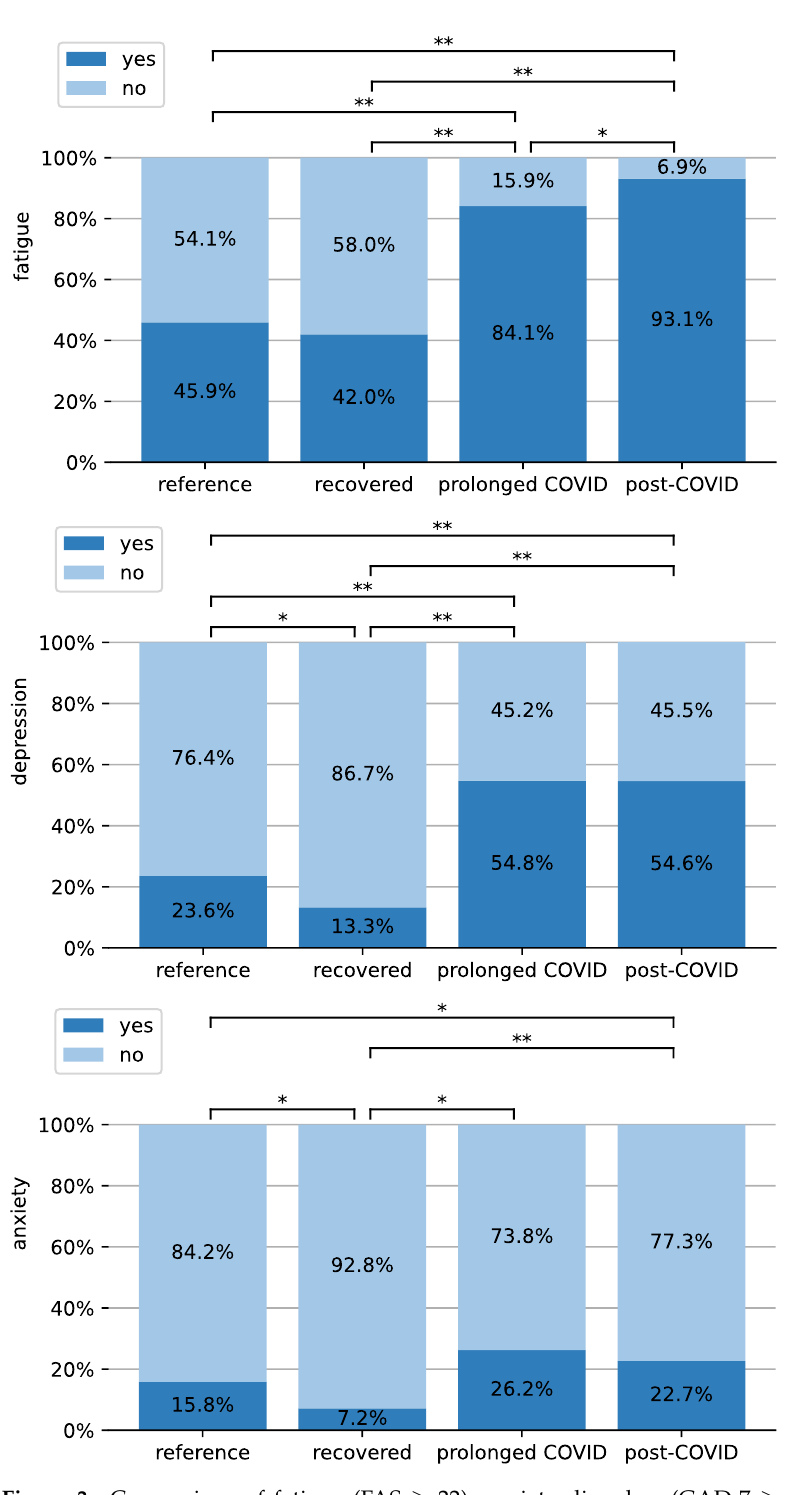
Figure 3. Comparison of fatigue (FAS ≥ 10) between all groups. Symbols: * : p